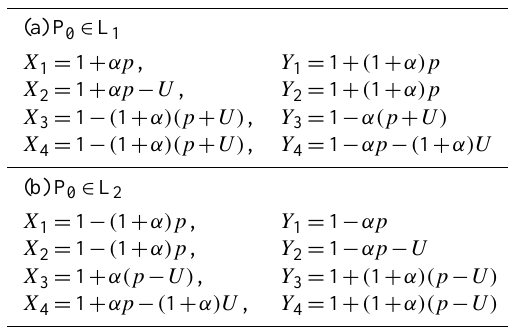
Table 1. Coordinates of the singular points of a limit